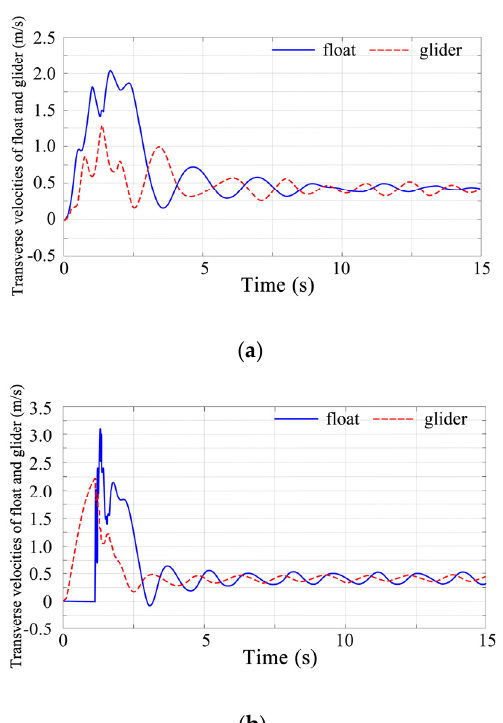
Figure 9. Transverse velocities of float and glider ( a ) Method 1 and ( b ) Method 2.